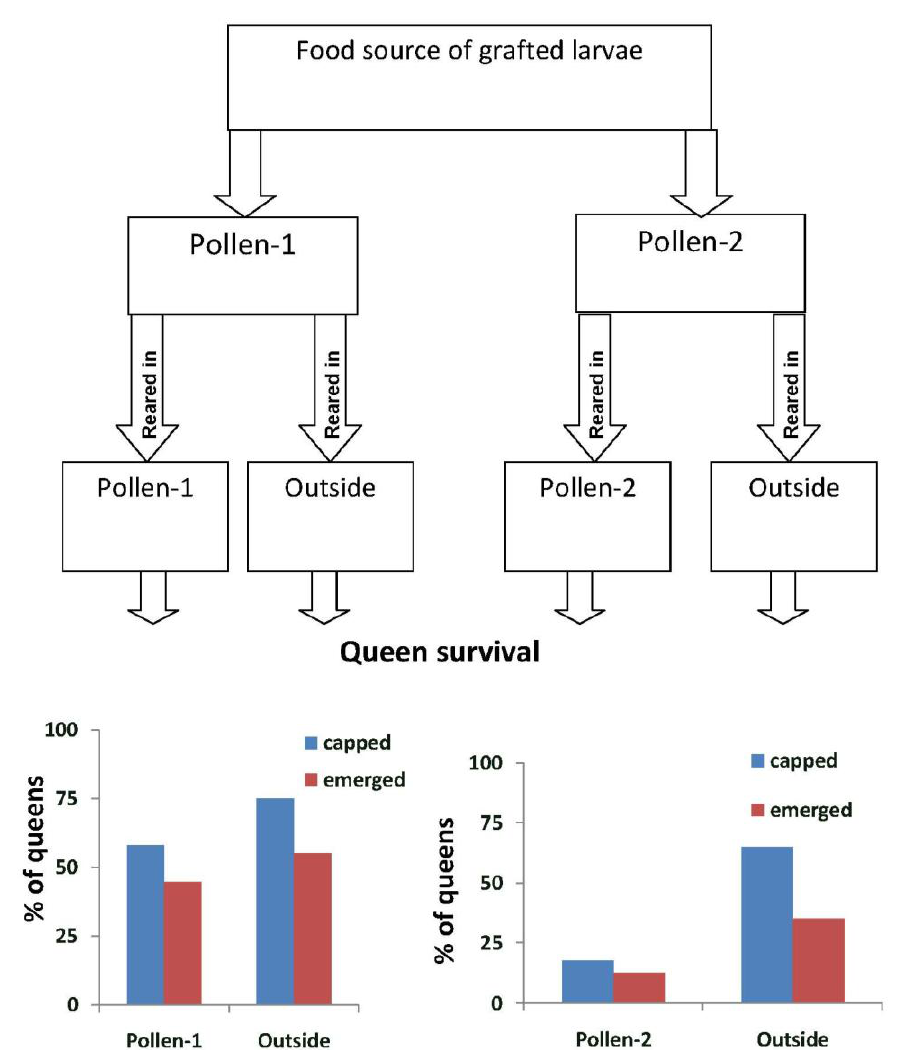
Figure 3. The percentage of queen cells that were capped and had emerged queens when larvae were grafted from colonies in an enclosed flight area (EFA) that were fed pollen with chlorpyrifos alone (Pollen-1), or with chlorpyrifos and Pristine ® fungicide (Pollen-2). The larvae were reared into queens in the colonies fed pollen-1 or 2 or in open foraging colonies outside the EFA (Outside). Percentages of larvae grafted from colonies fed pollen-1 that survived to the capped stage did not differ between those reared in colonies fed pollen-1 (57.9%) or in outside colonies (75%) ( X 2 = 1.65, p = 0.198). The percent that emerged also did not differ ( X 2 = 0.55, p = 0.457). Significantly fewer larvae from colonies fed pollen-2 and reared in those colonies survived to the capped stage ( X 2 = 13.54, p < 0.0001) and emerged as queens compared with those reared in outside colonies ( X 2 = 4.21, p = 0.04). More larvae survived to the capped brood stage and emerged as queens when grafted from and reared in colonies fed pollen-1 compared with